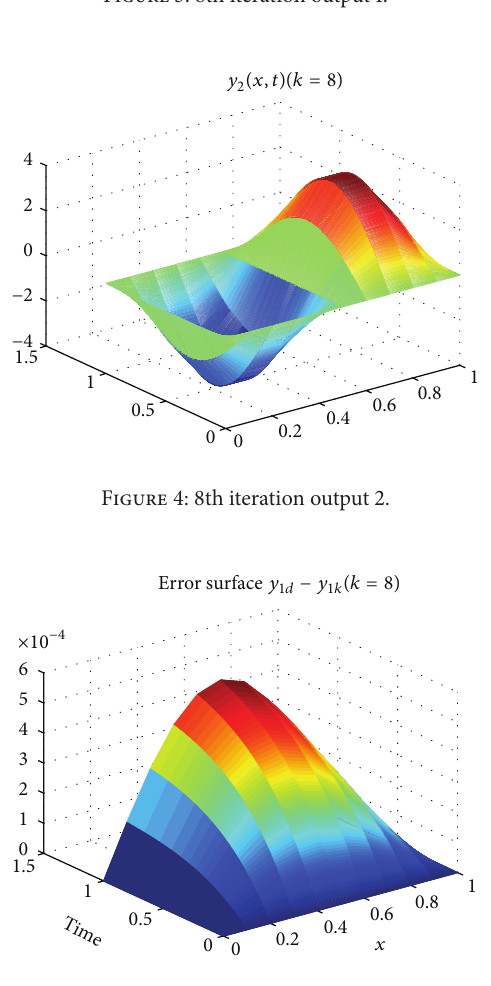
Figure 5: Error surface 1 (iteration 8).